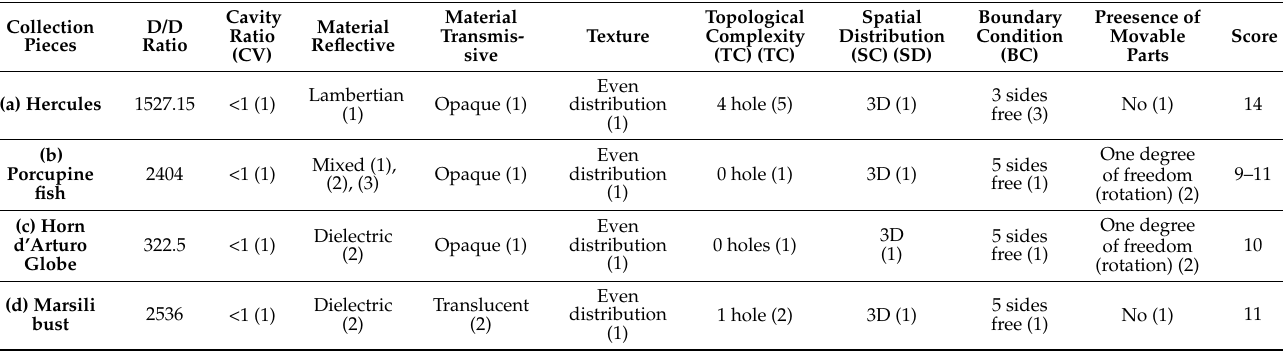
Figure 21. Comparison of our denoise solution ( a ) with the original BM3D ( b ) and the image not denoised ( c ). Table 2. Features evaluation of collection